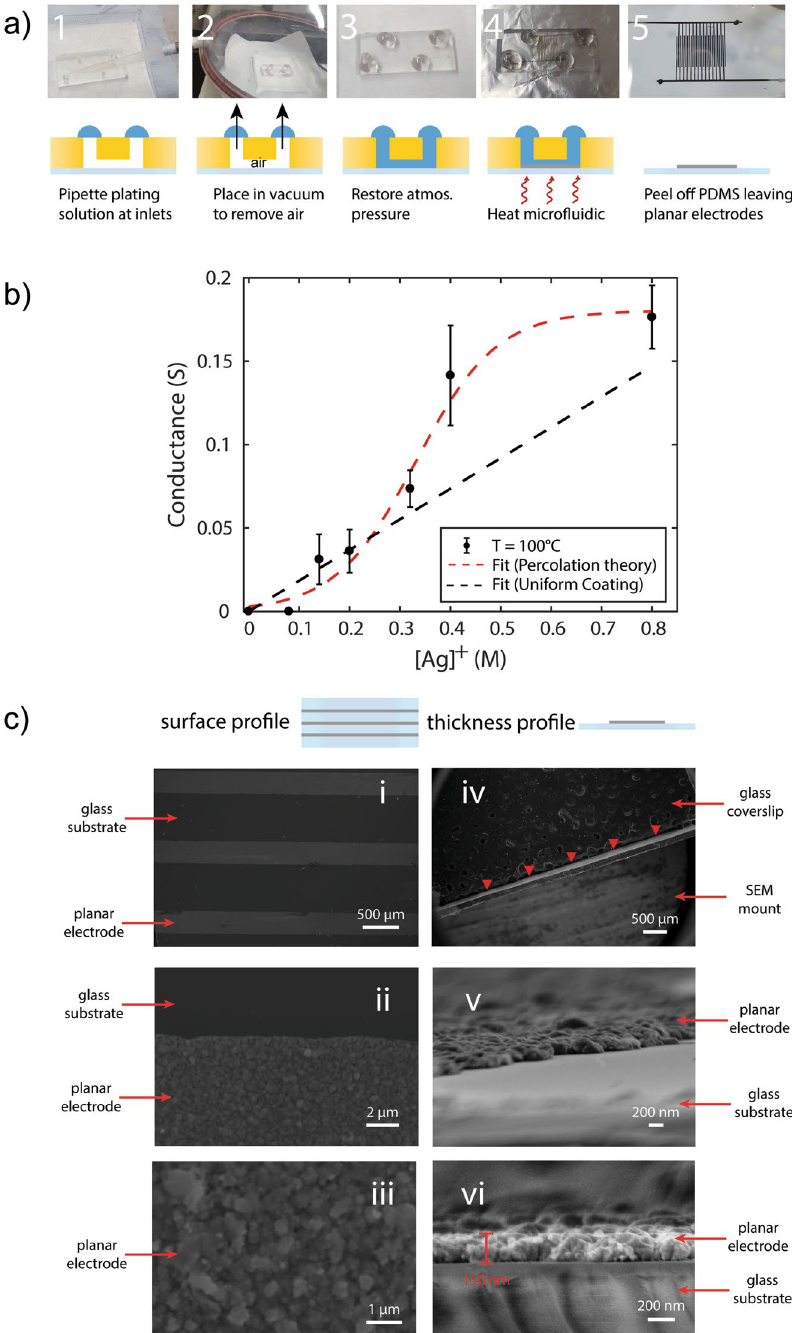
Figure 1. Deposition and characterisation of electrodes. ( a ) Illustration of the plating process: 1, a PDMS mould is drilled with inlet holes and reversibly bonded to a glass coverslip or slide; 2, plating solution is pipetted so as to completely cover the inlets; 3, the microfluidic device is placed in a desiccator and allowed to degas for 5 minutes; 4, atmospheric pressure is restored allowing the plating solution to fill the vacuum in the main and side-channels; 5, the device is heated on a hotplate for 5 minutes at 100 °C; and 6, the PDMS mould is detached from the glass slide leaving planar electrodes. Shown are interdigitated electrodes (width = 300 μ m, spacing = 200 μ m). Scale bar corresponds to a length of 10 mm. ( b ) To determine the functionality of the electrodes, conductivity of main channel electrode is measured. Conductance varies as a function of the initial silver ion precursor concentration and shown are the results using electrodes cured at 100 °C. The dashed black line is an estimate of conductance when making the uniform coating assumption, which would apply in the case of non-porous films. The dashed red line is a Boltzmann fit to the data (R 2 = 0.97) suggesting that electrode formation is in line with percolation theory. ( c ) SEM analysis of the planar electrodes produced on glass coverslips. i-iii: Images show the surface profile of the electrodes at increasing magnification. iv-vi: Images show the lateral profile of the electrodes to determine electrode thickness. The red arrow heads in iv indicate the location of the planar